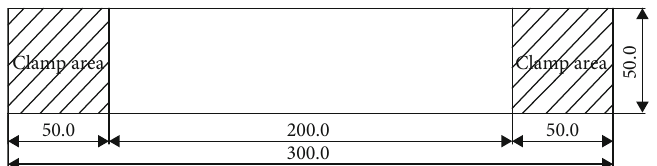
Figure 2: Detailed illustration of uniaxial tensile specimen (mm).